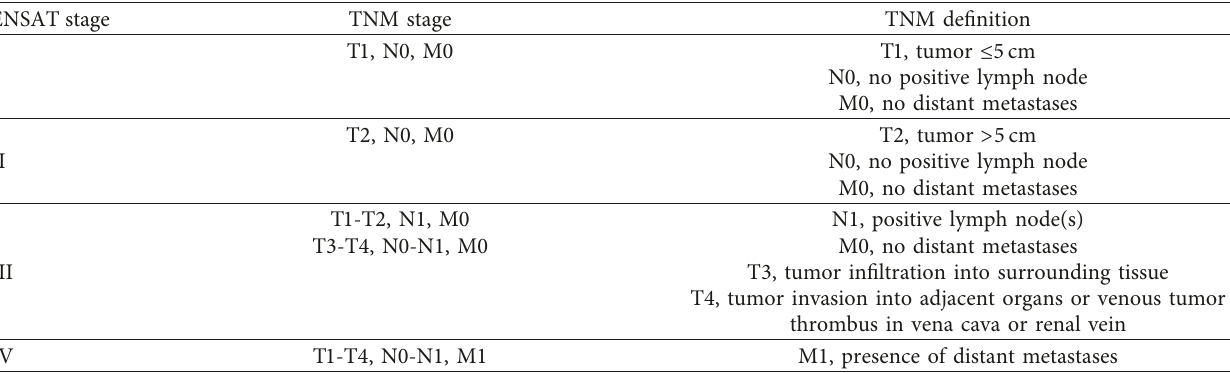
Figure 2: (a) Macroscopical view of the adrenal mass and right kidney. (b) The adrenal mass with a nodular and extensive necrotic area at sectioning. (c) High mitotic activity with multifocal necrosis. (d) Extension of the neoplastic cells to the capsule. Table 3: Classification system for staging ACC [9,